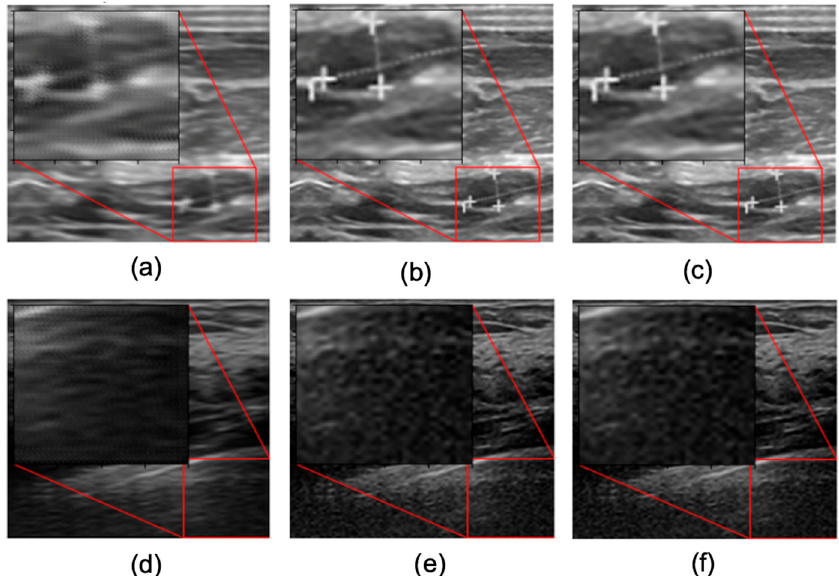
Figure 5. Reconstructed images at the beginning and the end of the training phase: ( a ) Dataset A: HR at epoch 1 (28.40 dB), ( b ) Dataset A: HR at epoch 100 (35.76 dB), ( c ) Dataset A: Ground truth, ( d ) Dataset B: HR at epoch 1 (24.40 dB), ( e ) Dataset B: HR at epoch 100 (29.36 dB), and ( f ) Dataset B: Ground truth.